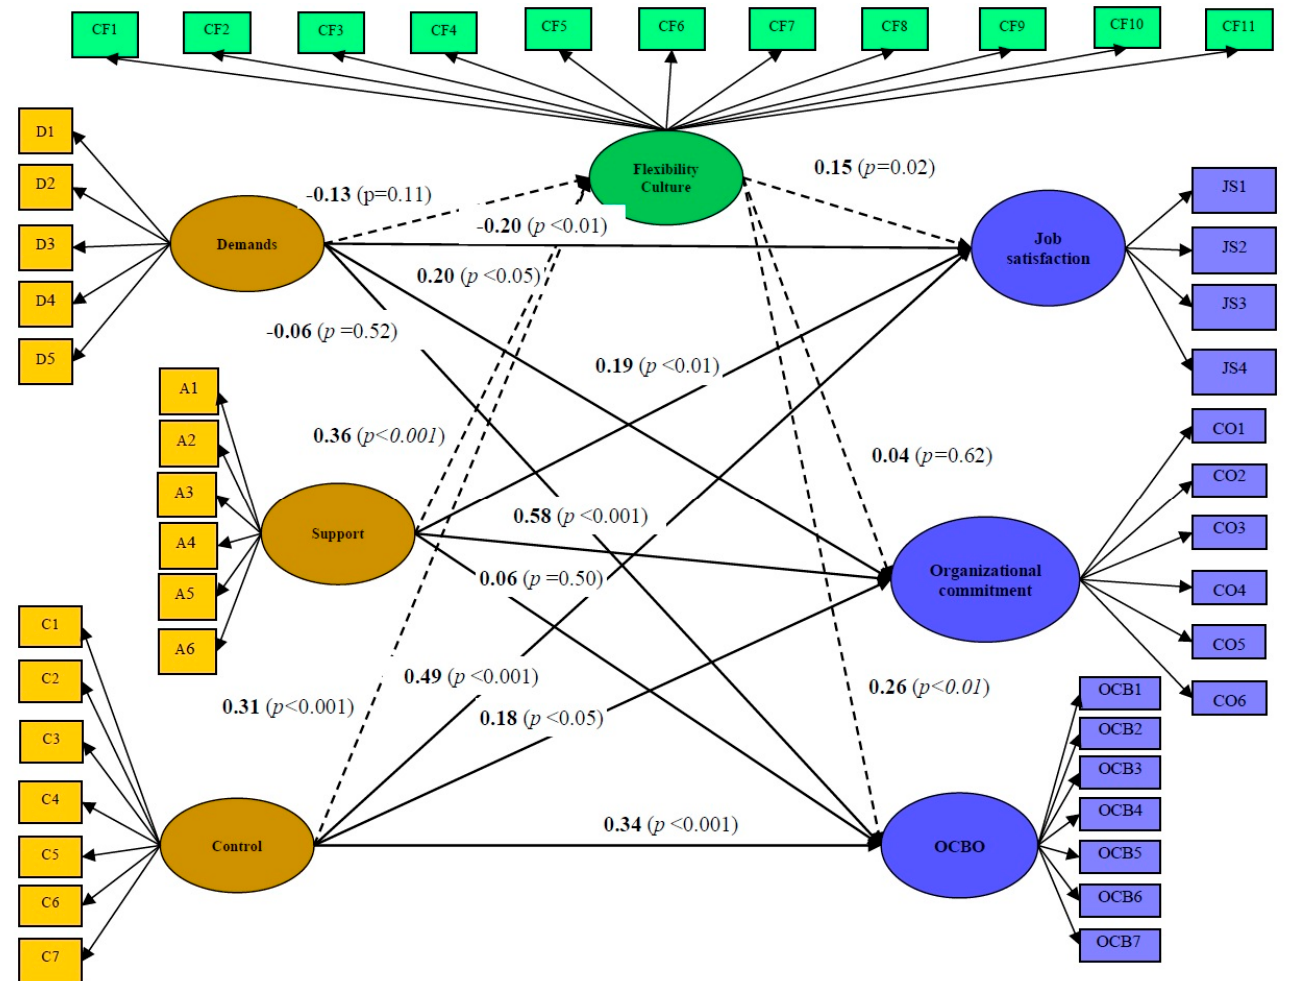
Figure 2. Structural model. Standardized Regression Coe ffi cients (t